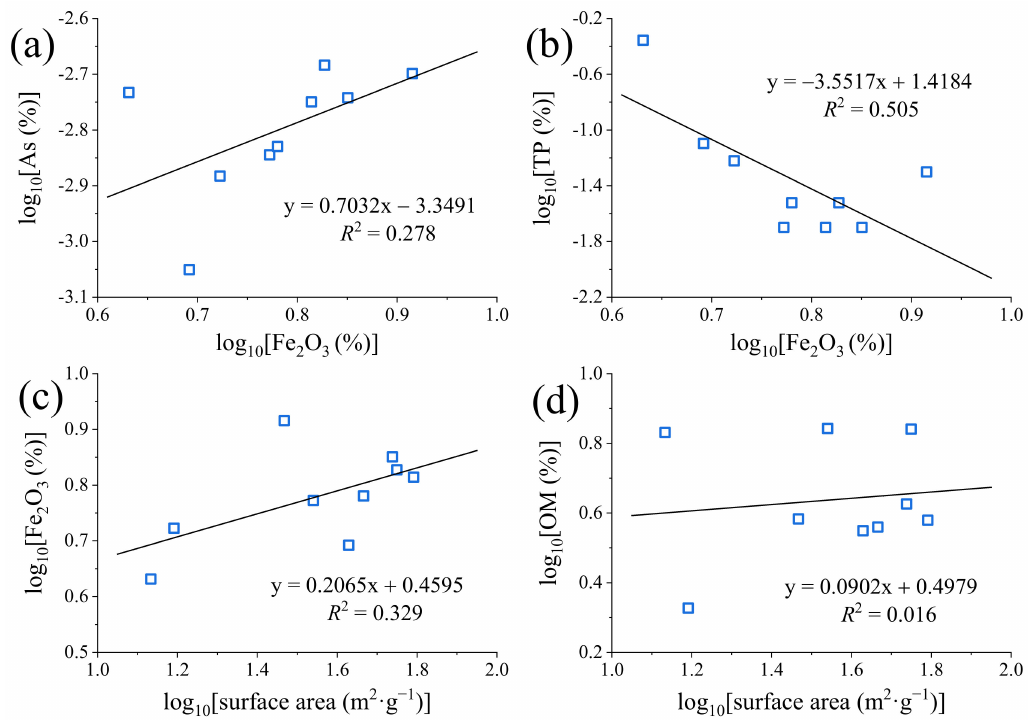
Figure 5. Correlation between the ( a ) Fe 2 O 3 content and As content, ( b ) Fe 2 O 3 content and total phosphorus (TP) content, ( c ) Fe 2 O 3 content and surface area, and ( d ) organic matter (OM) content and surface area for the collected actual